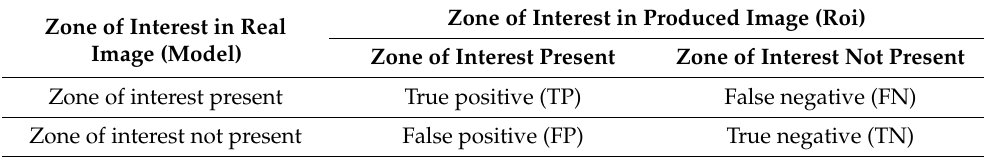
Table 2. Situations produced comparing the zones of interest in the confusion matrix.